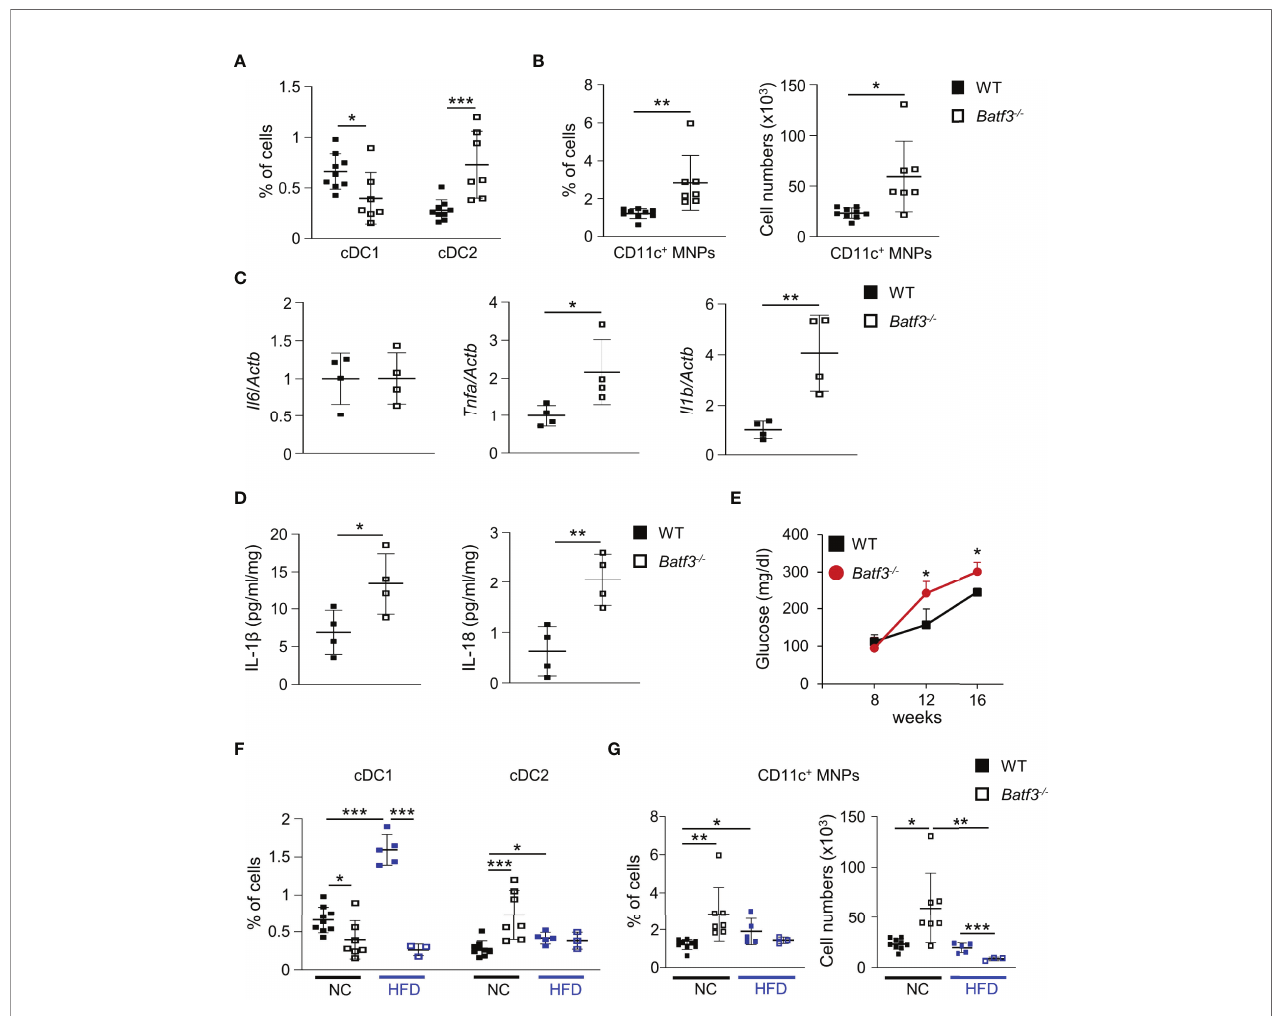
FIGURE 3 | BATF3-de fi ciency leads to a shift toward a pro-in fl ammatory phenotype in the lamina propria. (A, B) Quanti fi cation of colonic lamina propria cDC1, and cDC2 (A) , and CD11c + MNPs, percentage of cells (left panel), total number of cells per large intestine (right panel) (B) of WT and Batf3 -/- mice at 16 weeks (WT, n = 9; Batf3 -/- , n = 7). (C) mRNA expression of indicated genes in the cecum of 16-week-old mice measured by qPCR. All data were normalized to expression of Actb and represented as fold changes compared to WT mice (n = 4/group). (D) IL-1 b and IL-18 secretion from colon explants of WT and Batf3 -/- mice at 16 weeks measured by ELISA (n = 4/group). (E – G) WT and Batf3 -/- mice were fed a HFD from 8 to 16 weeks of age. (E) Fasting blood glucose levels during HFD. (F, G) Quanti fi cation of cDC1, and cDC2 (F) , and CD11c + MNPs, percentage of cells (left panel), total number of cells per large intestine (right panel) (G) of 16-week- old WT and Batf3 -/- mice on normal chow or HFD (NC: n = 7-9/group; HFD: n = 3-5/group). Data are represented as means ± SD. Statistical signi fi cance was determined by Student ’ s t -test. * p < 0.05, ** p < 0.01, *** p <